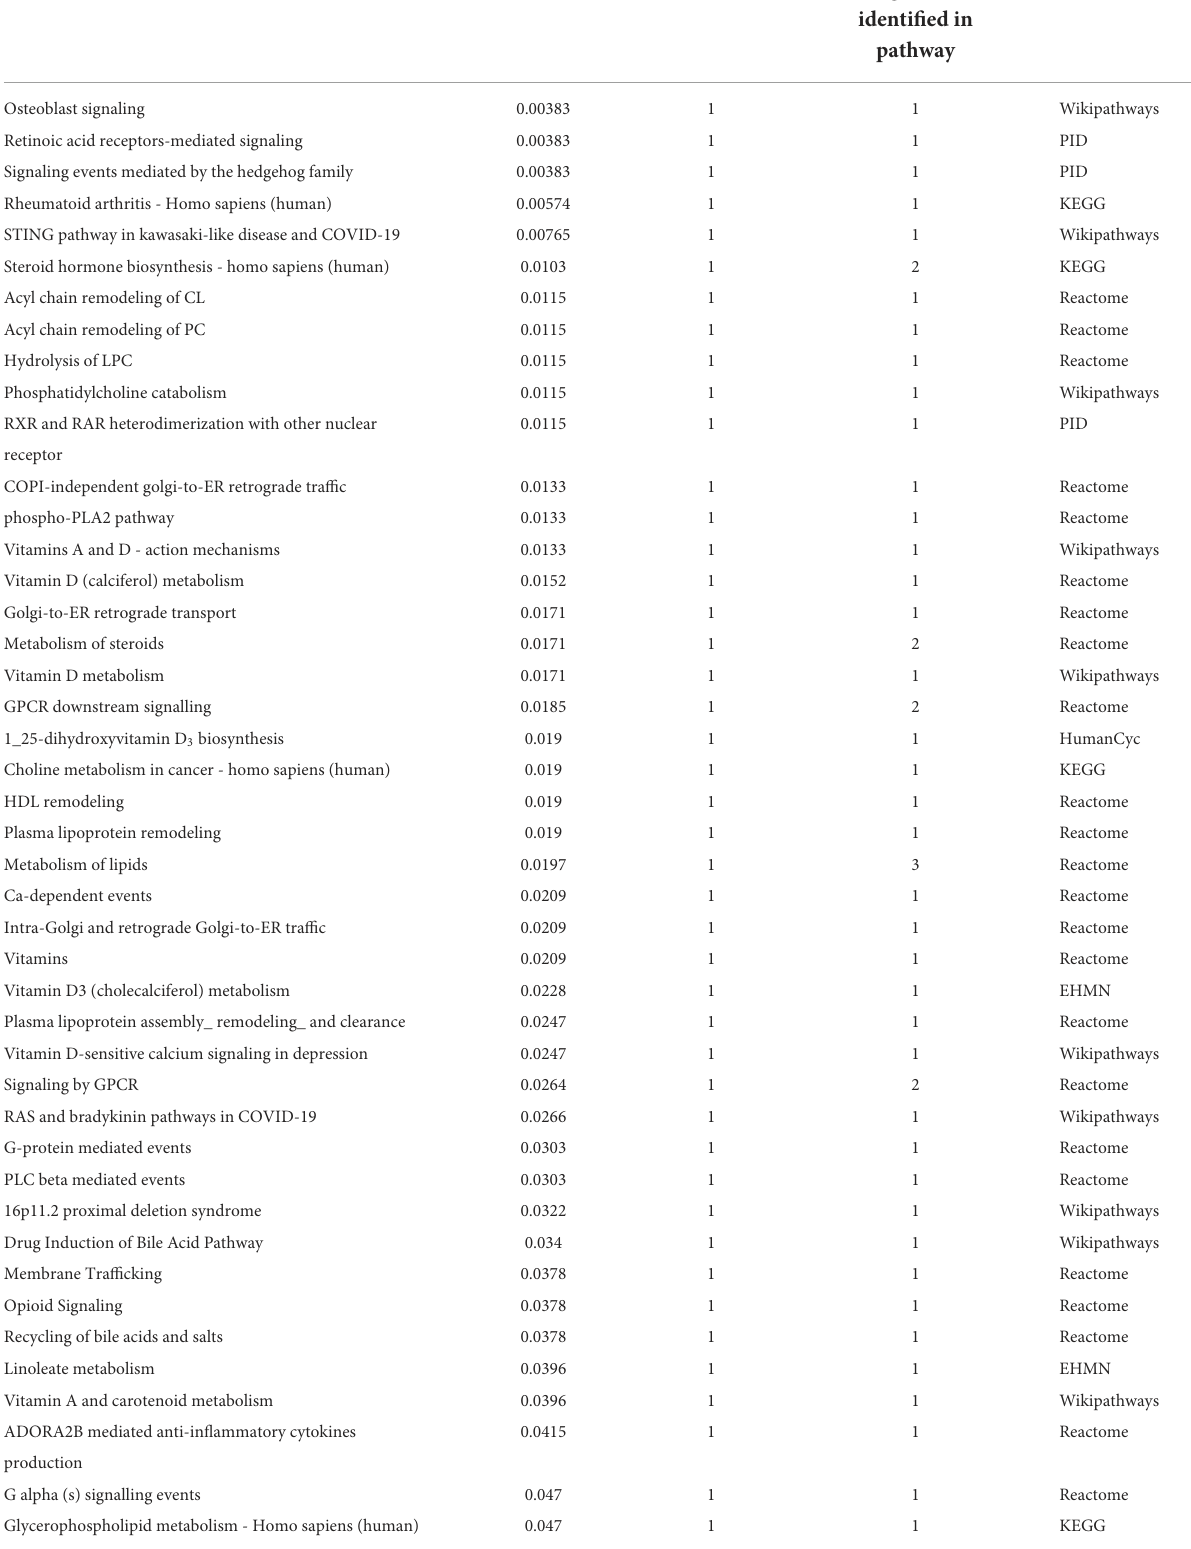
TABLE 3 Significantly enriched metabolic pathways in UCA patients compared to UCNA ( p <